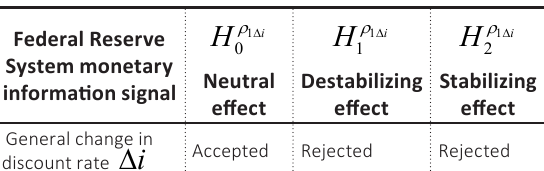
Table 3. Testing results for advanced